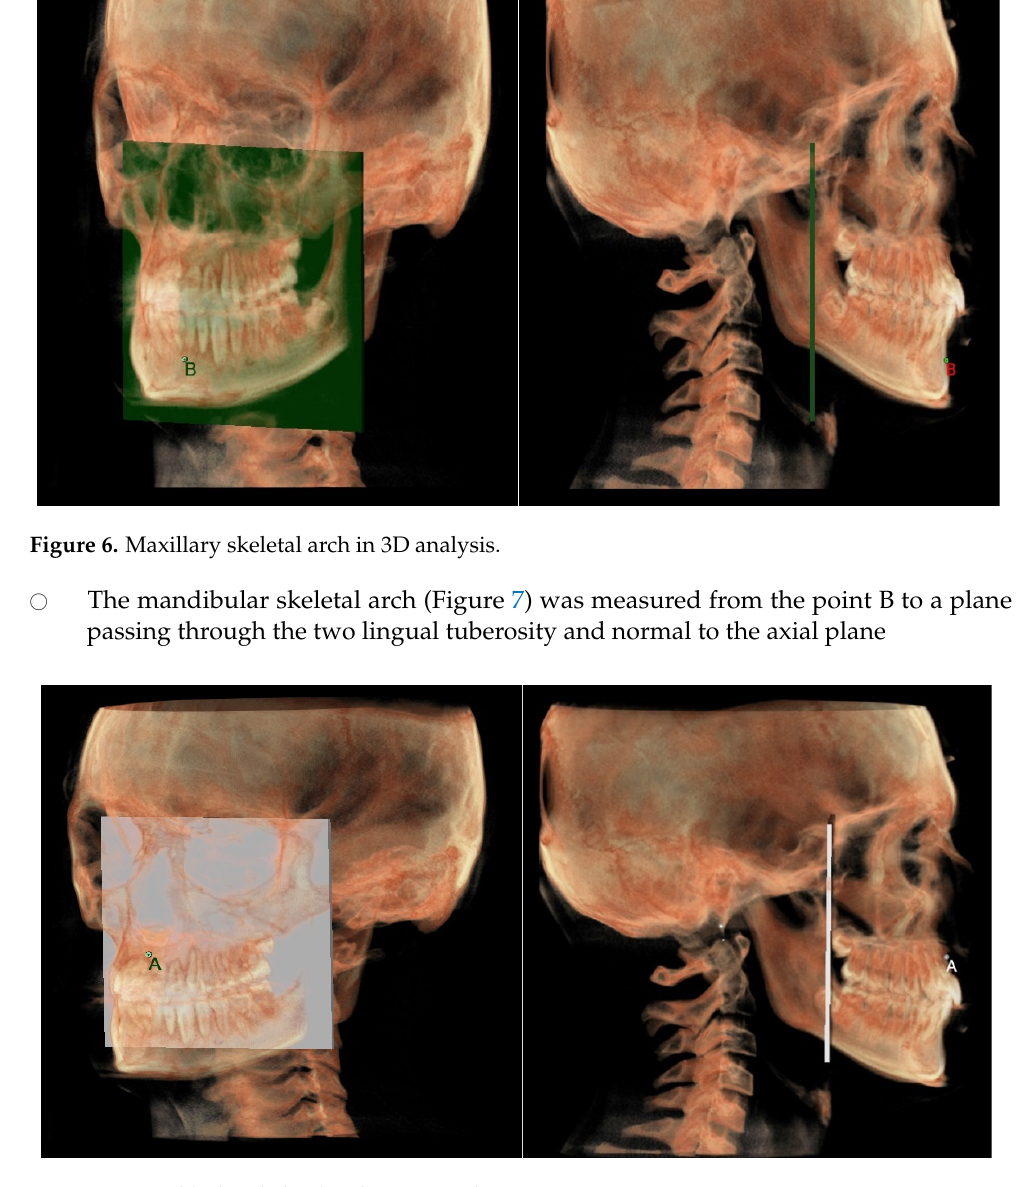
Figure 7. Mandibular skeletal arch in 3D analysis.